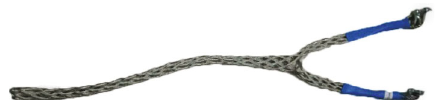
Figure 15: Anti-o ff -chain.